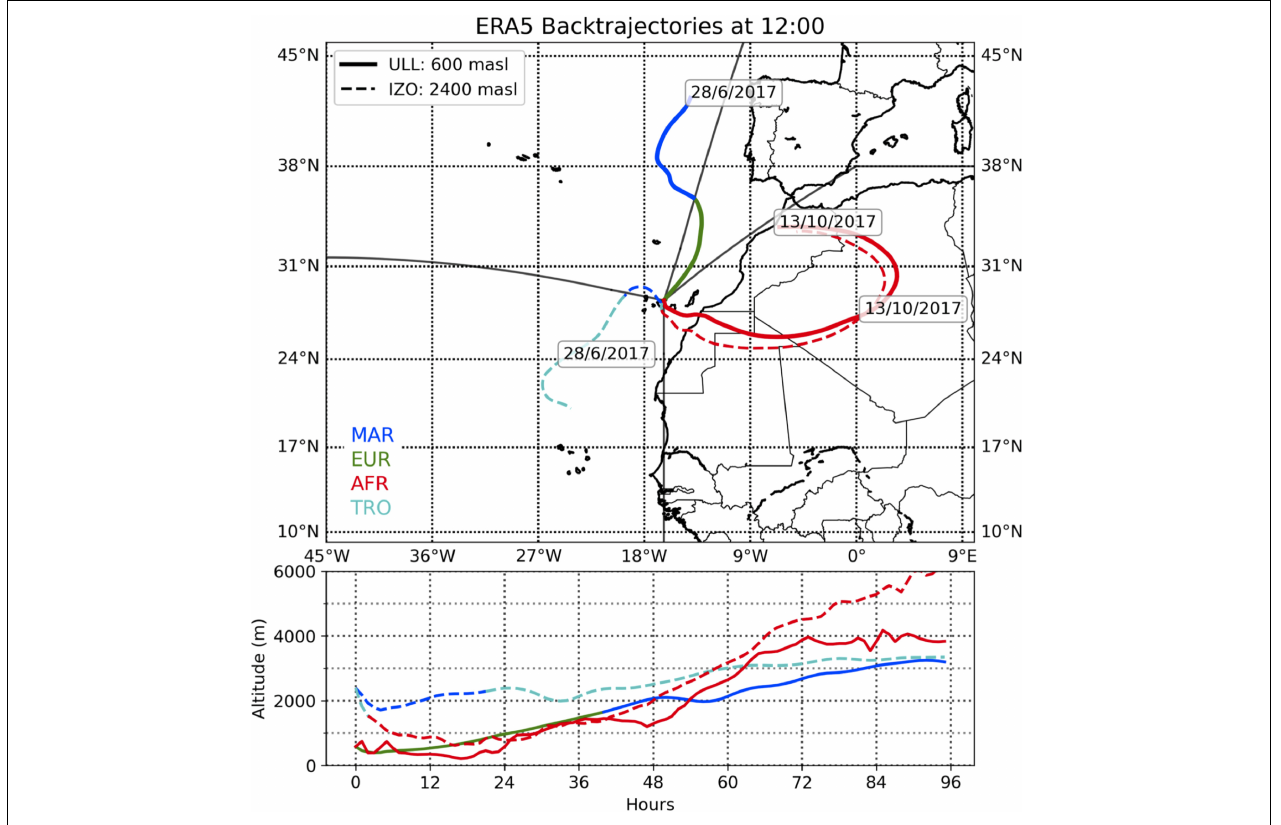
FIGURE 2 | Example of wind back trajectories for the La Laguna (LLA, solid line) and Izaña (IZO, dashed line) stations showing the different behaviors of the air masses that reach the sampling points. The colors of the back trajectories indicate the region through which the air masses flow: Marine (MAR, blue), European (EUR, green), African (AFR, red), and Tropical (TRO,